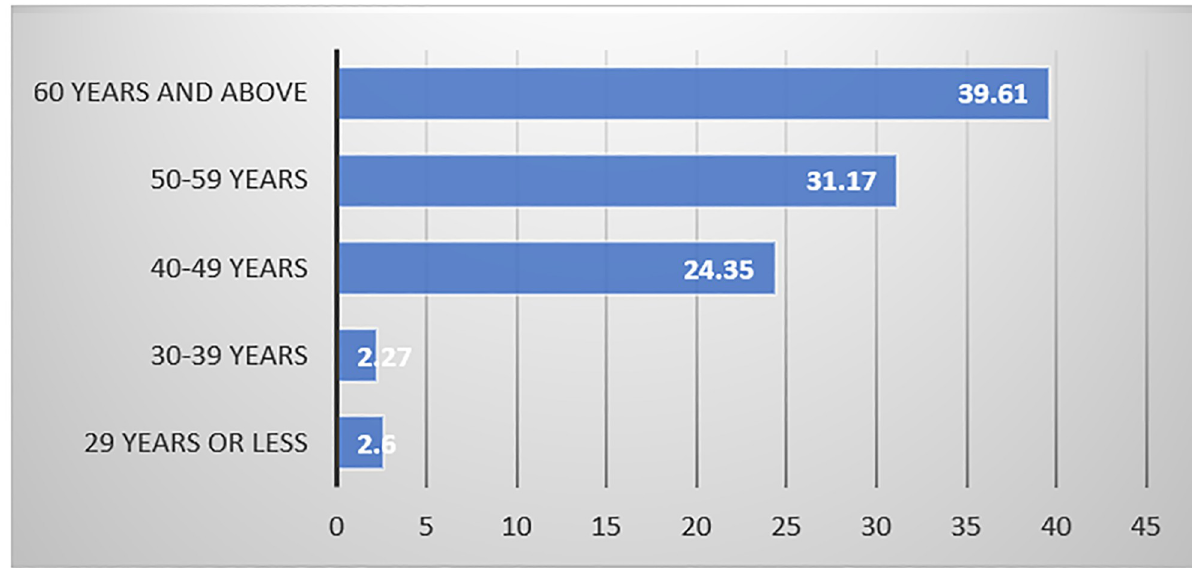
Fig 1. Percent of No VR uptake, by MCHS provider age (P < 0.001).